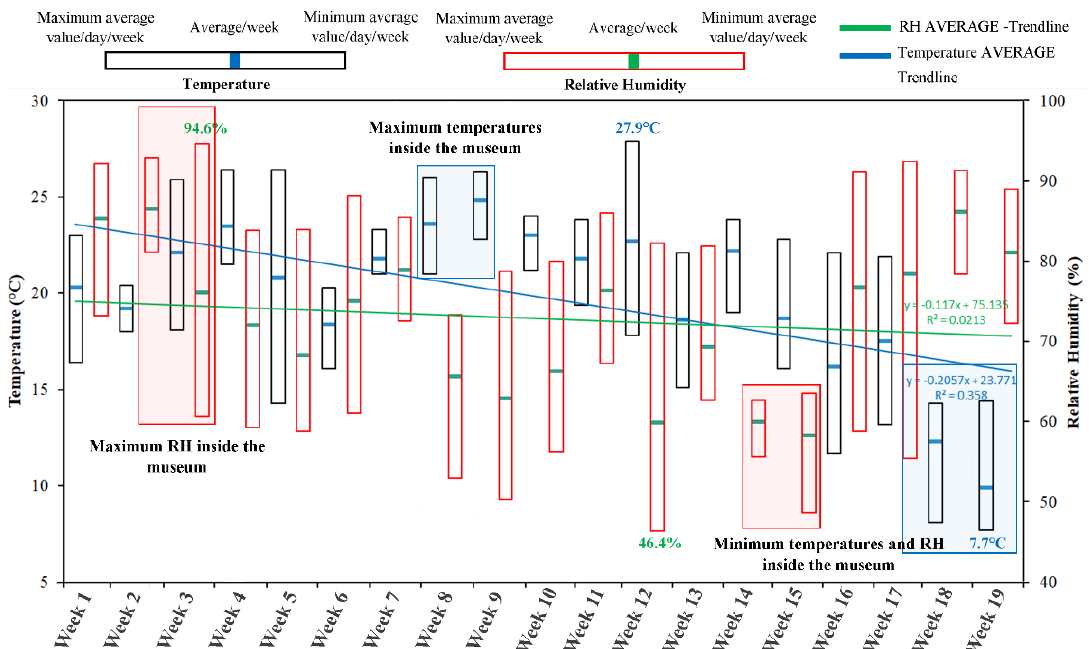
Figure 5. Outside fluctuations of temperature and relative humidity (RH) in terms of average values per week and minimum-maximum values/day/week.